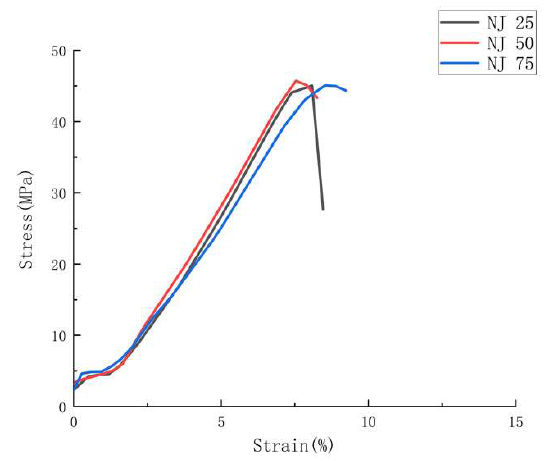
Figure 7. Representative stress-strain curves for tensile test amongst NJ batches.